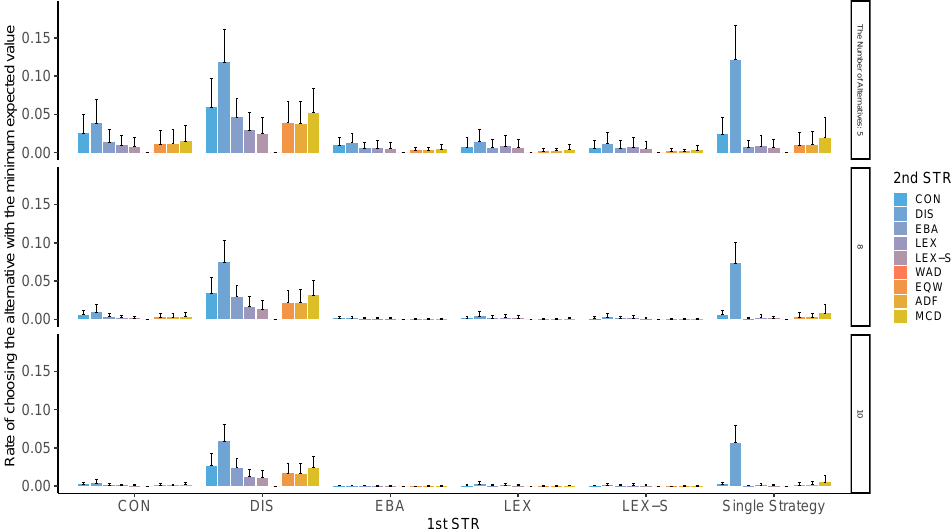
Figure 1. Worst-choice rate in two-stage decision-making when the number of alternatives left in the second stage is two for the different number of alternatives. Note: ADF: additive difference; CON: conjunctive; DIS: disjunctive; EBA: elimination by aspects; EQW: equal-weighted strategy; LEX: lexicographic; LEX-S: lexicographic semi-order; MCD: majority of confirming dimensions; STR: strategy; WAD: weighted